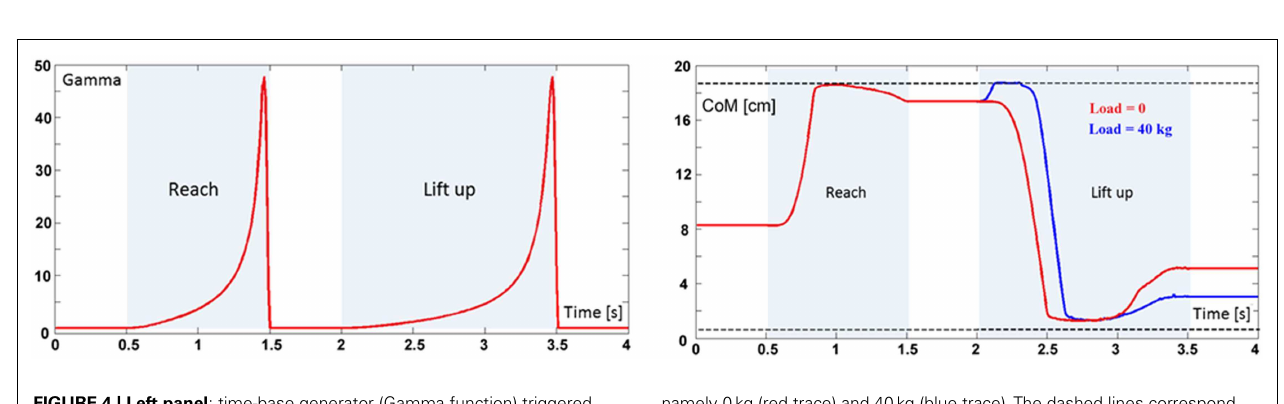
FIGURE 4 | Left panel : time-base generator (Gamma function) triggered twice in the reach and lift task. Right panel : evolution of the forward/backward component of the vertical projection of the body CoM on the standing surface during the reach and lift task, for two loads,